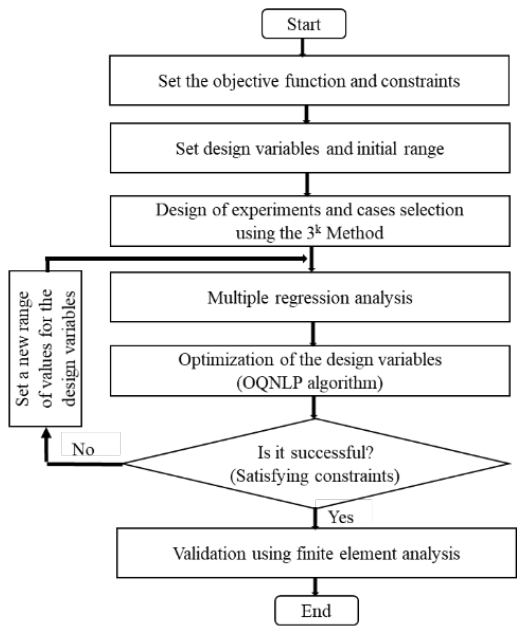
Figure 4. Flowchart for the optimization of the conformal array.